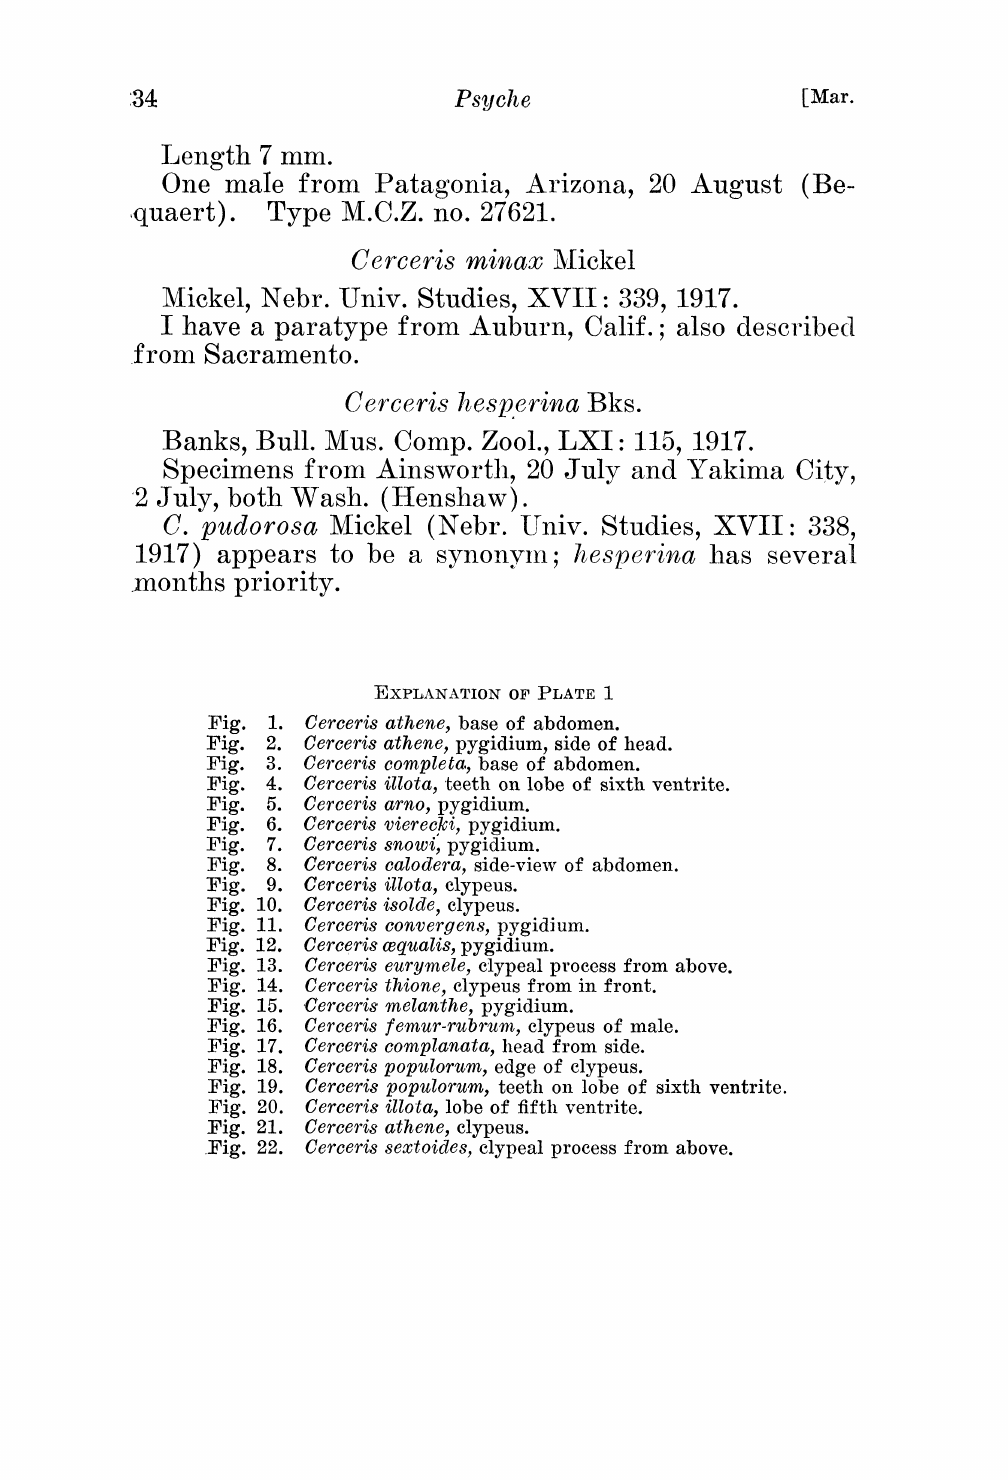
Fig. 1. Cerceris athene, base of abdomen. Fig. 2. Cerceris athene, pygidium, side of head. Fig. 3. Cerceris completa, base of abdomen. Fig. 4. Cerceris illota, teeth on lobe of sixth ventrite. Fig. 5. Cerceris arno, pygidium. Fig. 6. Cerceris vierecki, pygidium. Fig. 7. Cerceris snowi, pygidium. Fig. 8. Cerceris calodera, side-view of abdomen. :Fig. 9. Cerceris illota, clypeus. Fig. 10. Cerceris isolde, clypeus. Fig. 11. Cerceris convergens, pygidium. Fig. 12. Cerceris cequalis, pygidium. Fig. 13. Cerceris eurymele, clypeal process from above. Fig. 14. Cerceris thione, clypeus from in front. Fig. 15. Cerceris melanthe, pygidiuln. Fig. 16. Cerceris femur-rubrum, clypeus of male. Fig. 17. Cerceris complanata, head from side. Fig. 18. Cerceris populorum, edge of clypeus. Fig. 19. Cerceris populorum, teeth on lobe of sixth ventrite. Fig. 20. Cerceris illota, lobe of fifth ventrite. Fig. 21. Cerceris athene, clypeus. .Fig. 22. Cerceris sextoides, clypeal process from